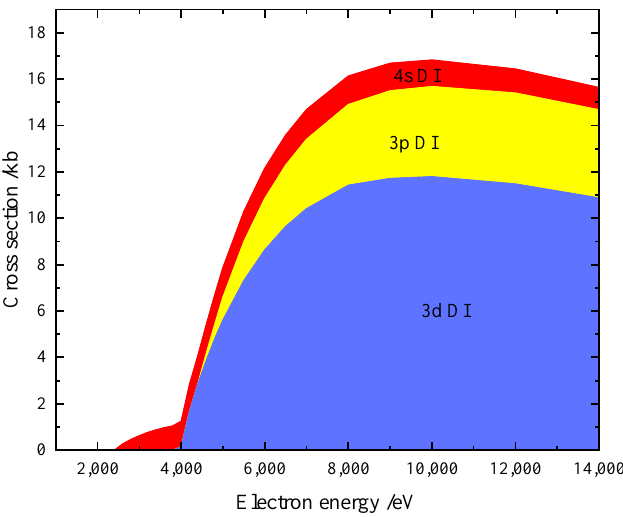
Figure 3. Accumulated DI cross-sections of ground state W 45 + . The shadow areas show contributions from different subshells (1.0 kb = 10 − 21 cm 2